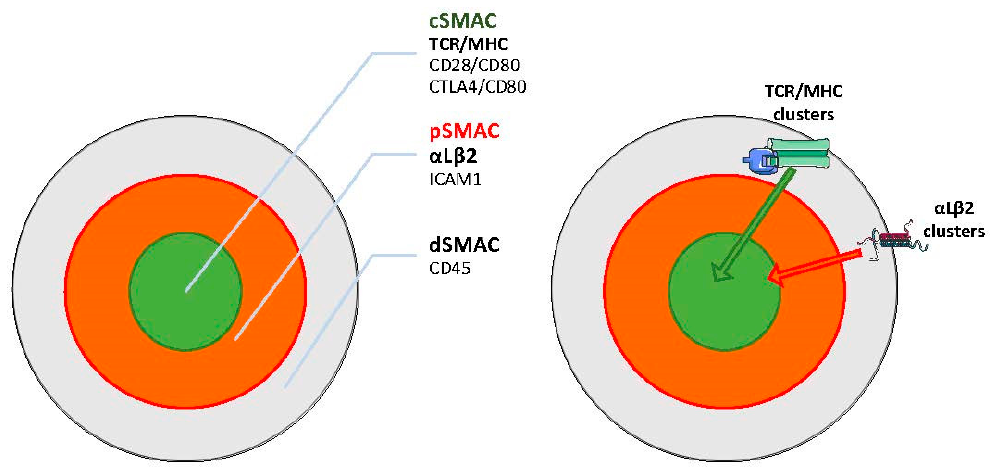
Figure 3. Immune synapse organization.